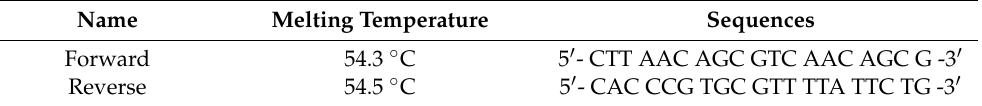
Table 1. Thymidine kinase (TK) primers used with their respective sequences and melting